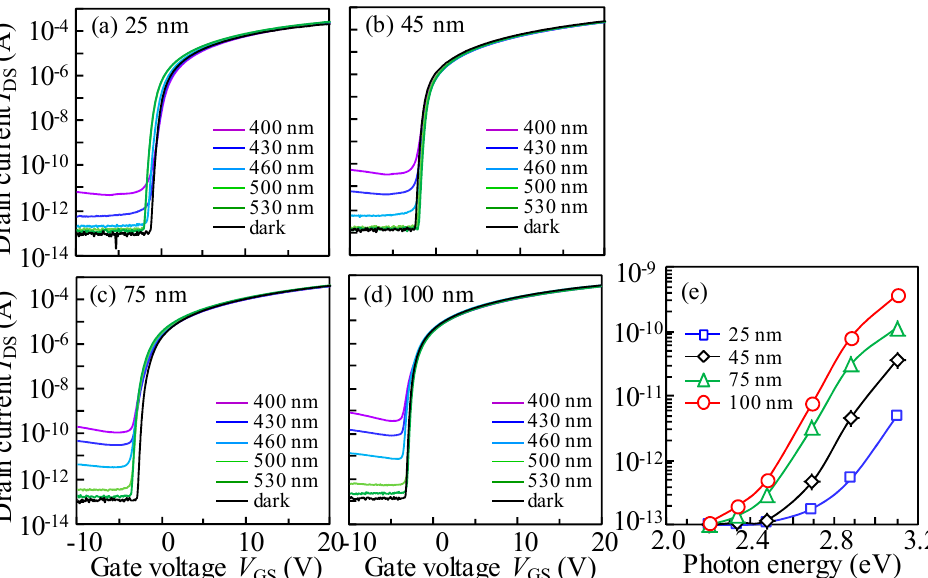
Figure 2. Variation in the OFF-current of the transfer curves in the reverse scan for TFTs with the T ITZO of ( a ) 25, ( b ) 50, ( c ) 75, and ( d ) 100 nm under photo-excitation with various wavelengths, and ( e ) the corresponding OFF-current variation as a function of incident photo-energy.